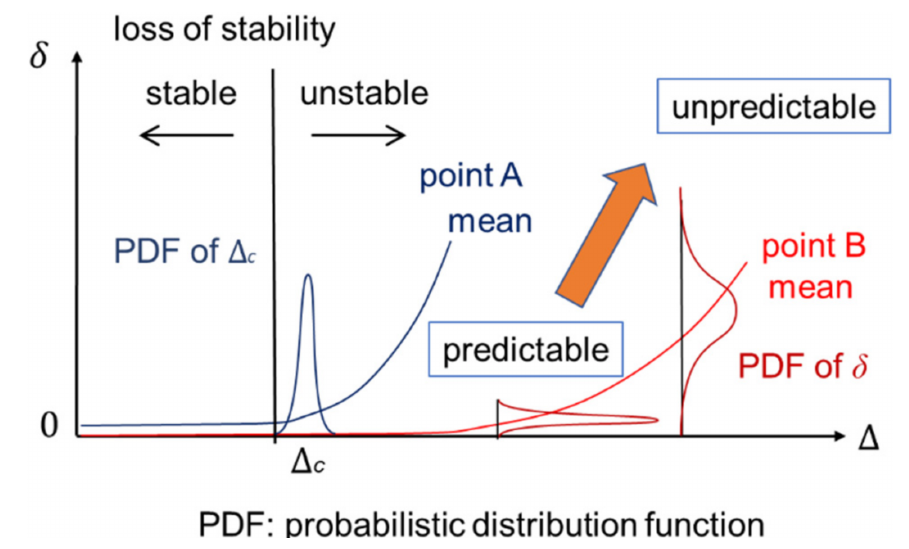
Figure 2. Evaluation of surface fault